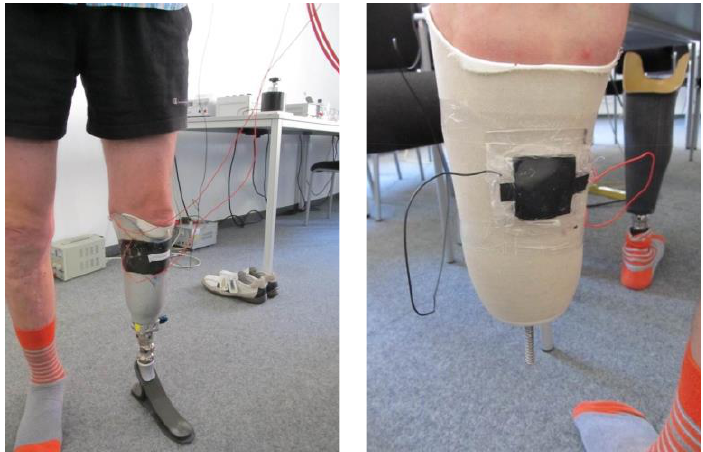
Figure 19. DE pressure sensor attached on the liner of a knee prosthesis for an experimental evalua- tion [100].